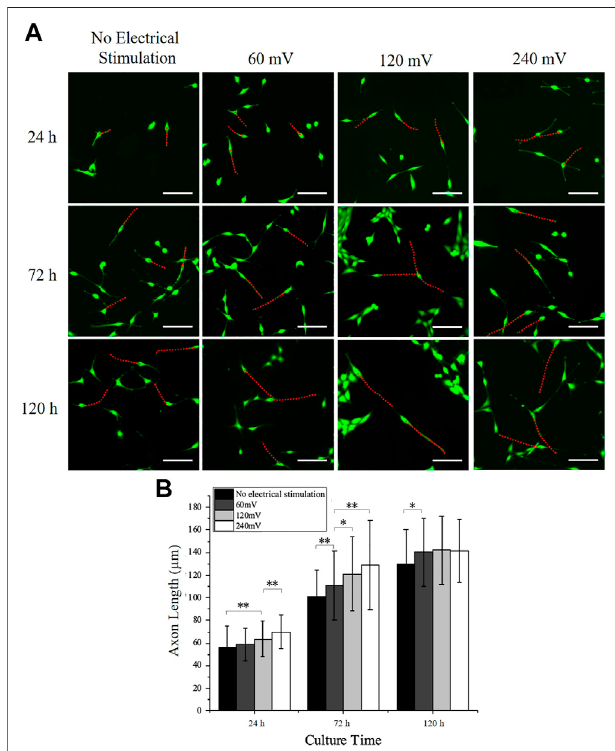
FIGURE 4 | PC12 cell axon outgrowth measurement under electrical stimulation. (A) Representative PC12 cells immuno fl uorescence images for all electrical stimulation groups. Scale bar: 100 μ m. (B) Axon length measurement of PC12 cells cultured on the electrodes. The signi fi cant difference between groups is indicated ( p , p < 0.05; pp , p < 0.01; n > 150 cells).